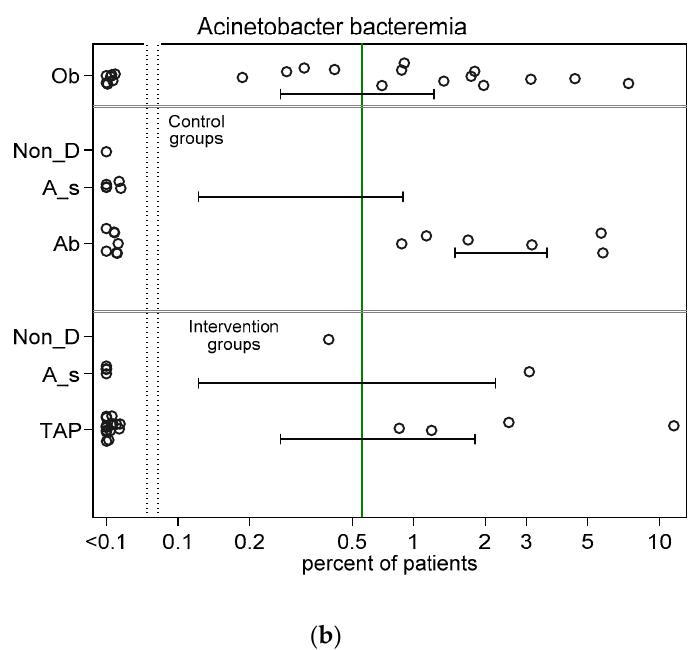
Figure 4. Scatter plots (logit scale) and 95% CI of Acinetobacter VAP incidence ( a ) and Acinetobacter bacteraemia ( b ) in component (control and intervention) groups of various methods of infection prevention in the ICU, excluding studies with ICU-LOS < 5 days (ESM Figure S4a,b show including studies with ICU-LOS < 5 days). The benchmark incidence in each plot is the summary mean derived from the observation studies (central vertical line). Abbreviations; Ob = observational; non-D is non-decontamination; A_s is anti-septic; Ab is antibiotic control group; TAP is topical antibiotic prophylaxis.